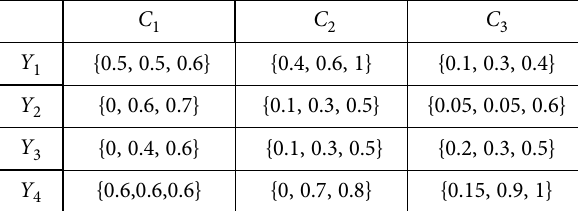
Table 5. Hesitant fuzzy decision matrix